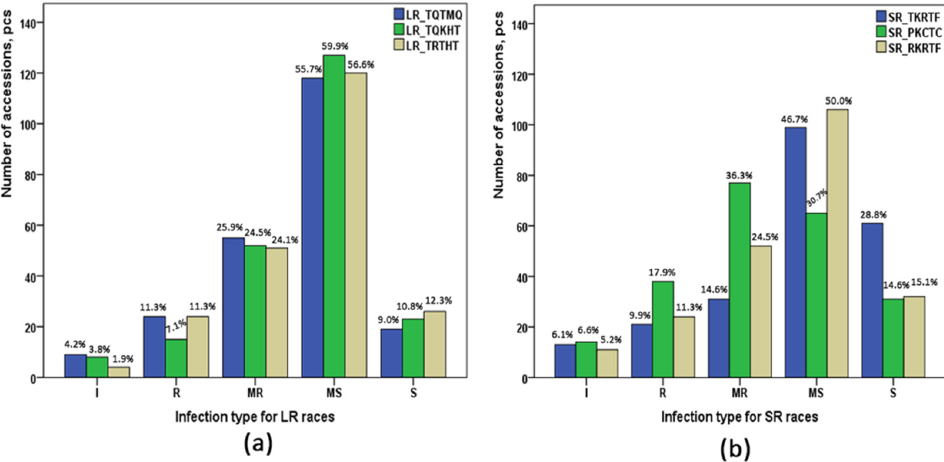
Figure 1. Summary of the reactions of 212 wheat cultivars and breeding lines to races of Puccinia triticina ( a ) and Puccinia graminis f. sp. tritici ( b ). I: immune; R: resistant; MR: moderately resistant; MS: moderately susceptible; S: susceptible.